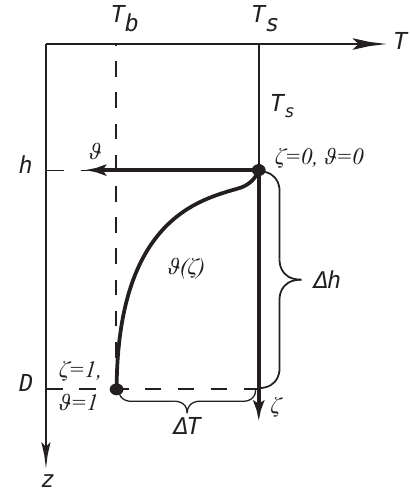
Figure 2. Schematic of a vertical temperature profile in a thermally stratified lake and the corresponding self-similarity coordinates. See Eqs. (1)–(2) for the meaning of the